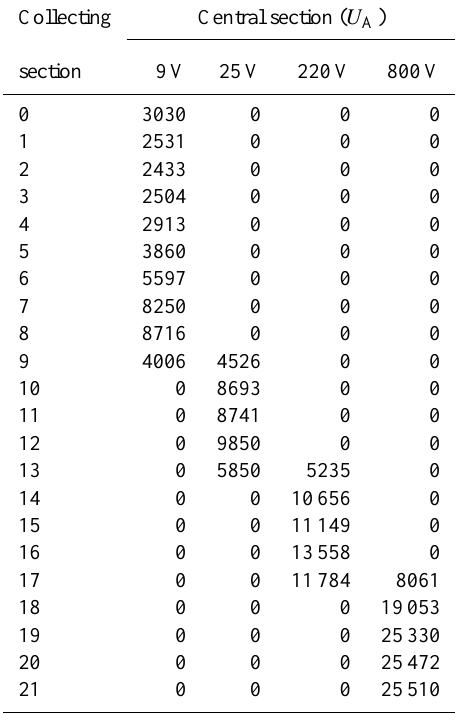
Table 1. The electrical capacitance (in pF) between collecting sec- tions and the four central sections of the NAIS mobility